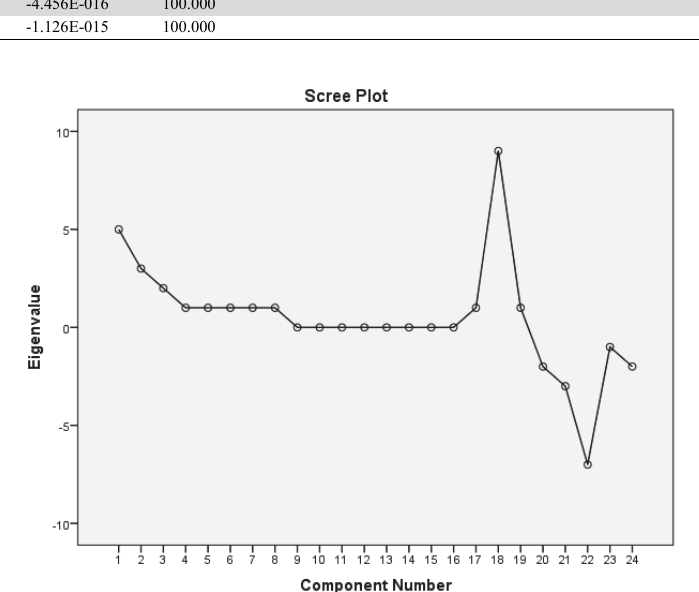
Fig. 1. The results of Scree